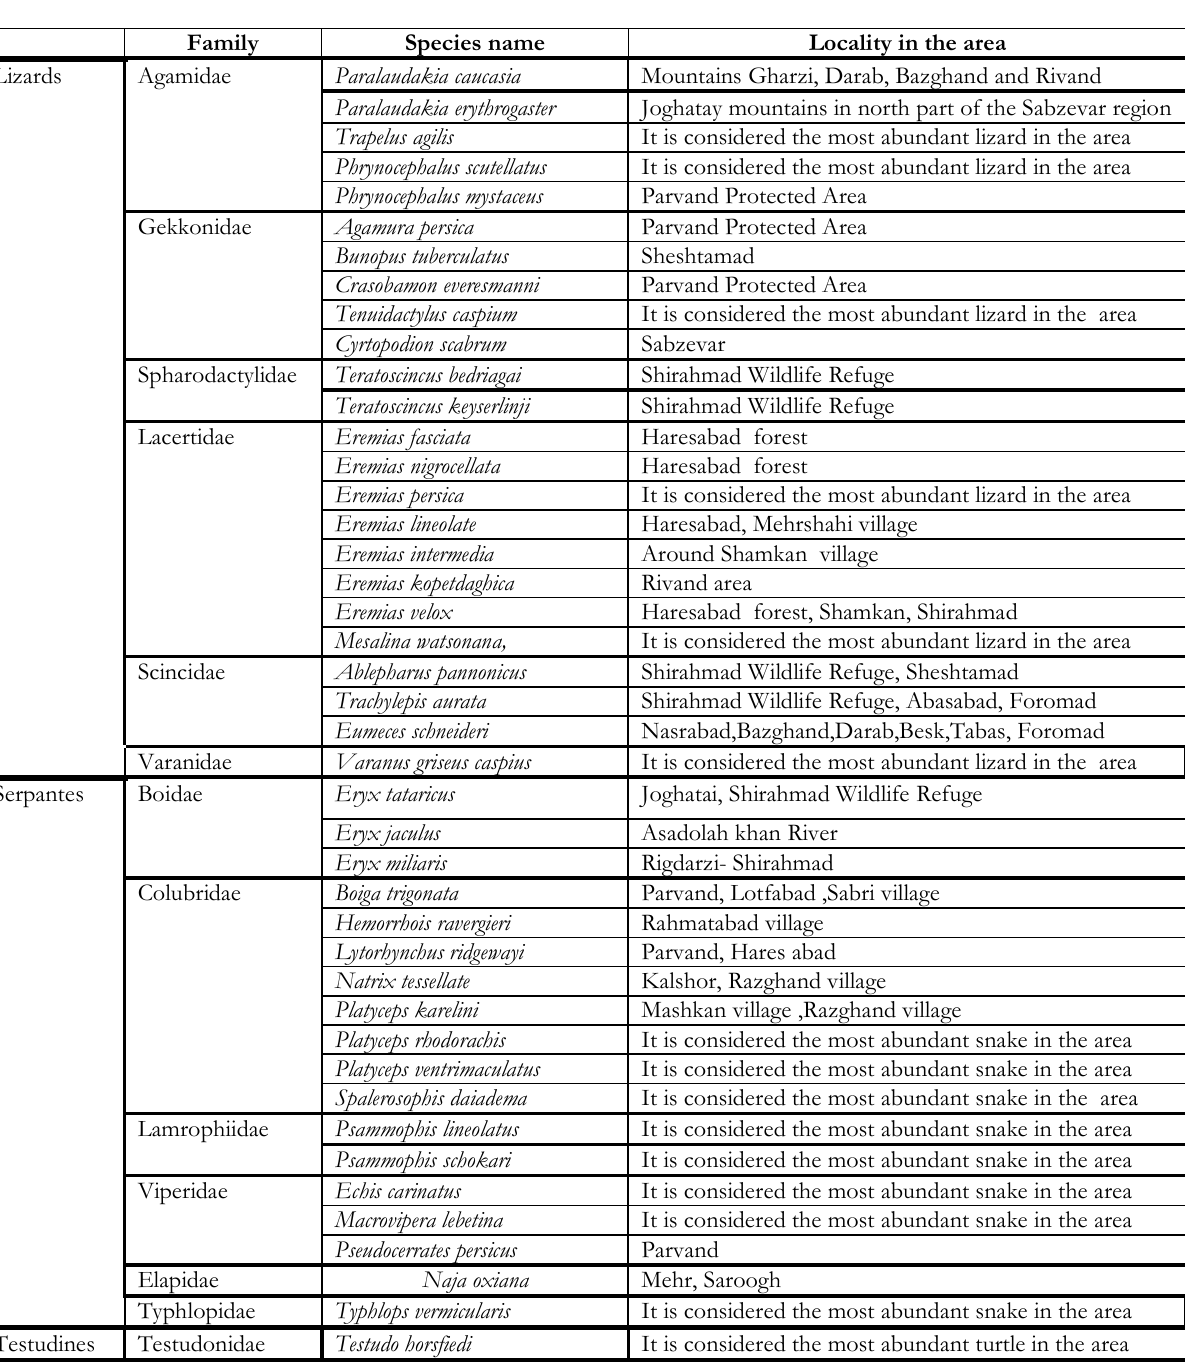
TABLE 1 . - Reptile species collected from